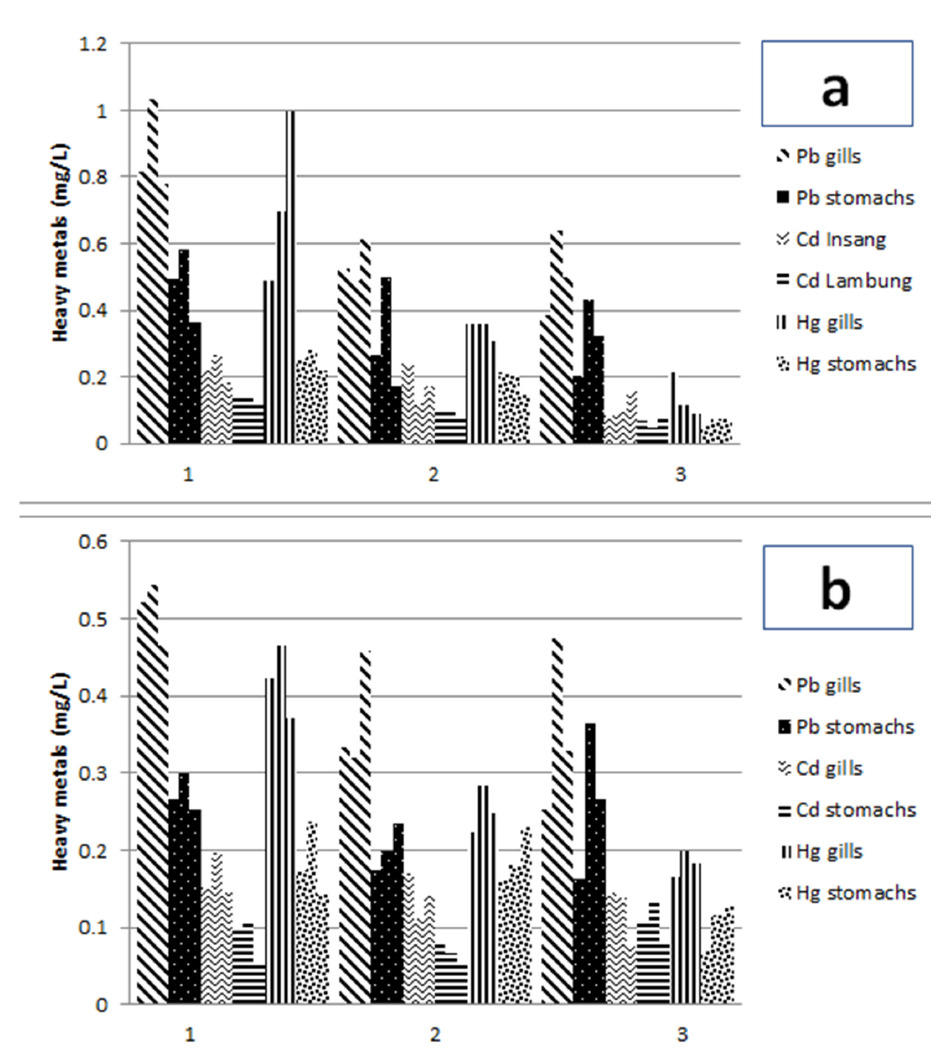
Figure 2. Heavy metal (Pb, Cd and Hg) content in the gills and stomach of ( a ) Crassostrea iredalei and ( b ) Crassostrea glomerata at the three stations. Station 1, Mayangan; Station 2, Kenjeran; Station 3, Gresik